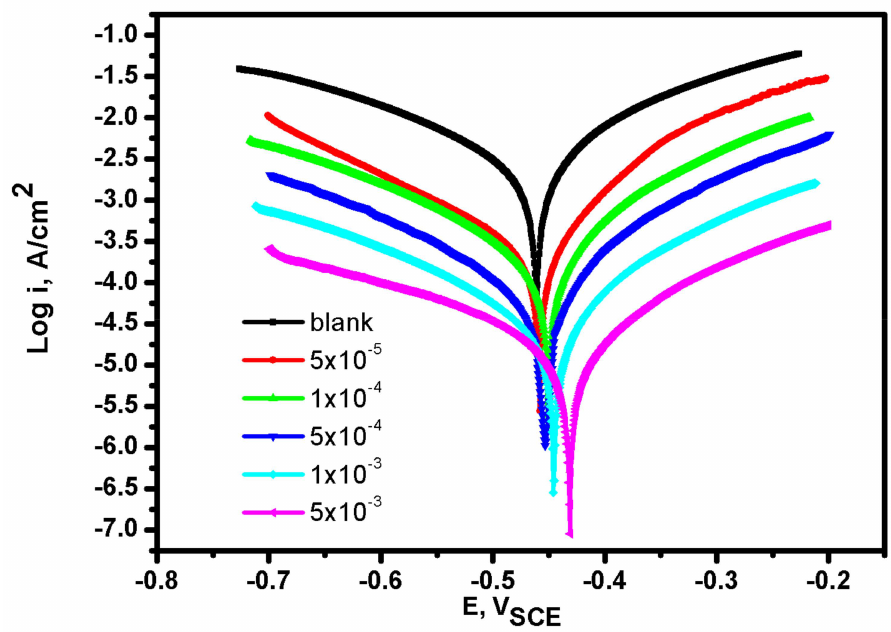
Figure 1. Potentiodynamic polarization curves for mild steel in presence of 1M HCl alone (blank) and containing different concentrations of BBMImIM ionic liquid at 25 ◦ C. Table 2. Electrochemical parameters obtained from potentiodynamic polarization measurements of mild steel alloy in 1 M HCl in the absence and presence of various concentrations of the investigated ionic liquids at 25 ◦